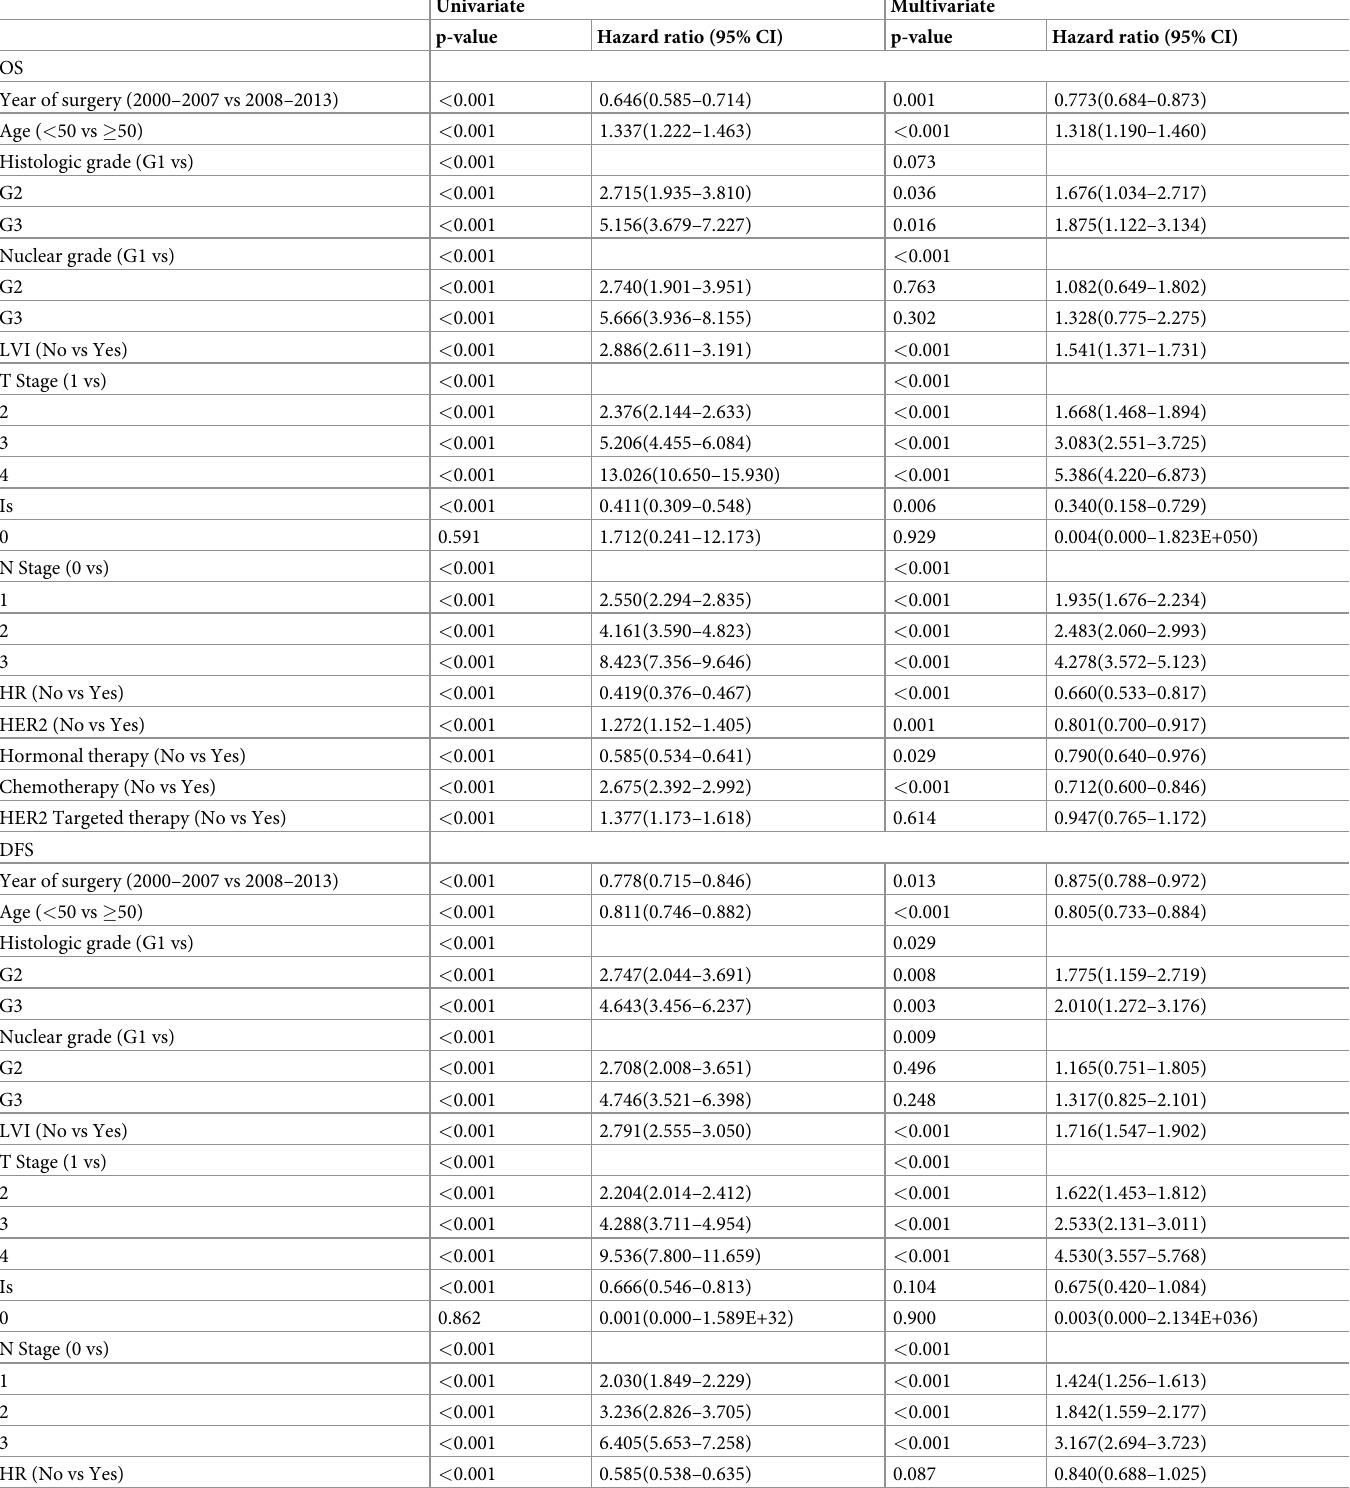
Table 2. Univariate and multivariate Cox regression analysis for OS, and DFS according to the period of